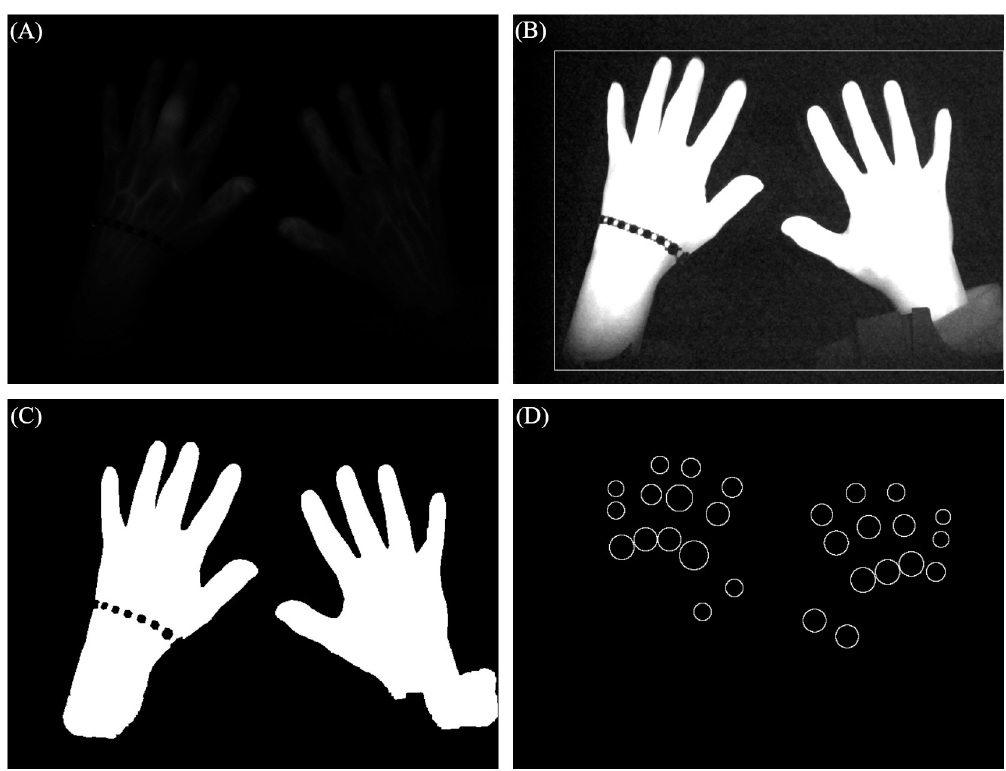
Fig 2. Steps of the binary mask extraction and result of the joint region calculation. (A) Extracted maximum image. (B) Enhanced image with bounding box. (C) Final binary mask. (D) Final joint areas.